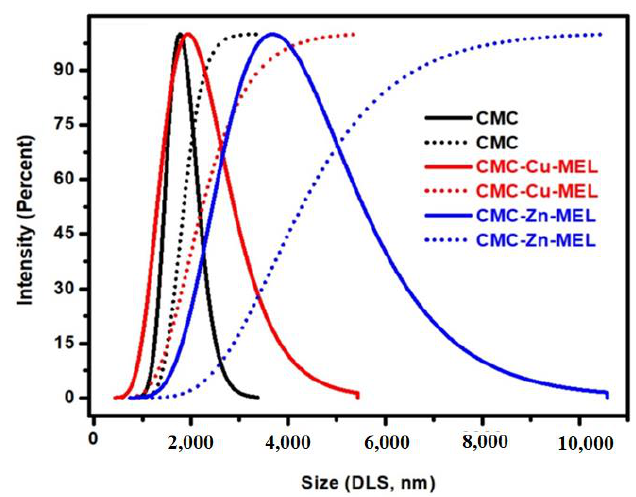
Figure 3. DLS analysis of CMC, CMC-Cu-MEL, and CMC-Zn-MEL.